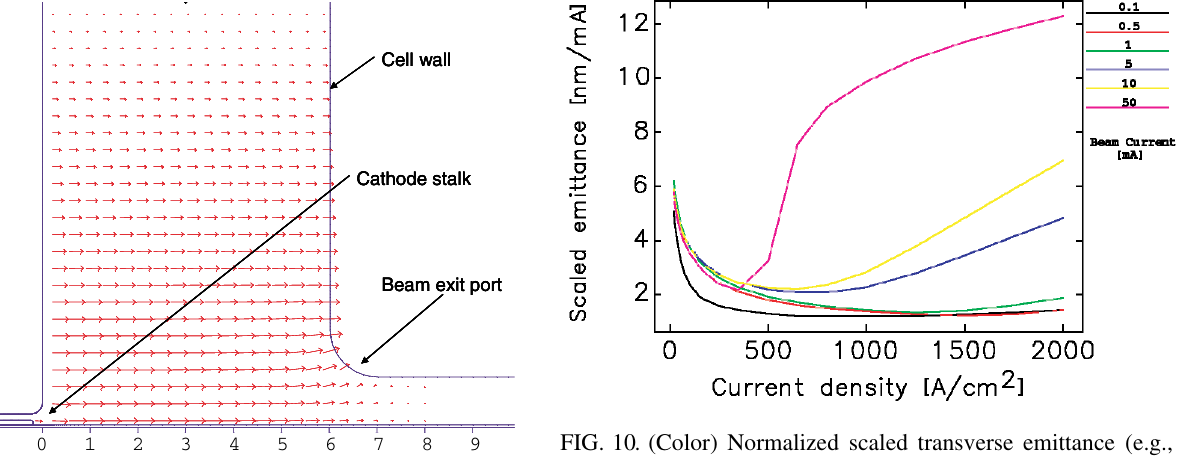
FIG. 10. (Color) Normalized scaled transverse emittance (e.g., normalized emittance divided by average beam current), as a function of time-average current density, for various beam currents.